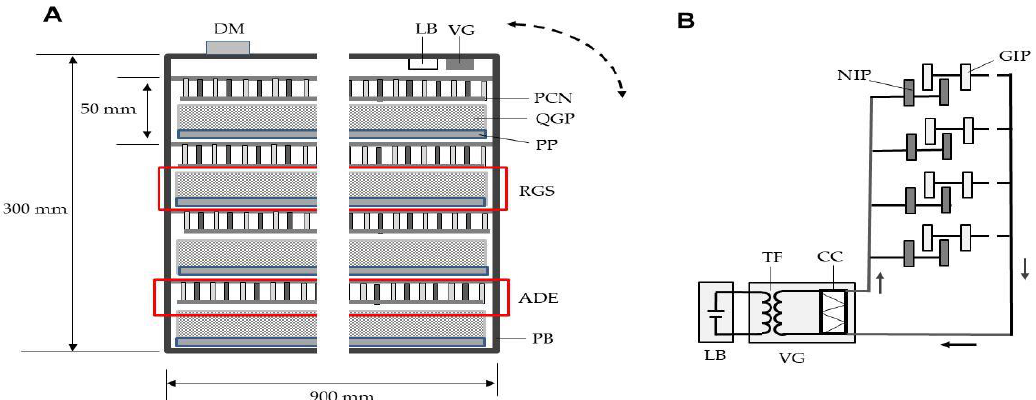
Figure 3. ( A ) The ADE-integrated insect eradicator (A-IE). Four ADEs were fixed in a polypropylene box. Four rice grain servers (a polypropylene board onto which a quadrate-grid plate was pasted and filled with insect-containing rice grains) were slid into the box beneath the ADEs. The ADEs were charged to − 7 kV using a voltage generator powered by a rechargeable lithium battery. The A-IE was rotated through 90 ◦ and then returned to the original position, causing the insects to climb to the top of the rice. The dotted arrow represents A-IE rotation. ( B ) Schematic of the non-grounded A-IE circuit. The arrow indicates the direction of electron movement. Abbreviations: DM, directional microphone; LB, lithium battery; VG, voltage generator; RGS rice grain server; ADE, arc discharge exposer; PCN, polyvinyl chloride net; QGP, quadrate-grid plate; PP, polypropylene plate; PB, polypropylene box; NIP, negatively charged iron plate; GIP, grounded iron plate; TF, transformer; CC, Cockcroft